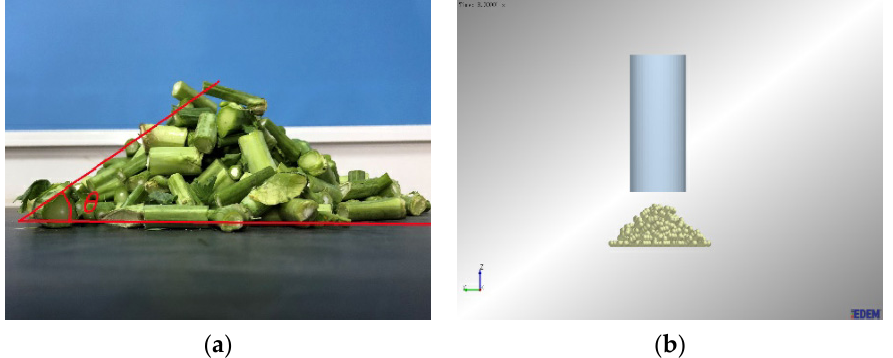
Figure 4. Experimental and simulation plots of the stacking angle. ( a ) Experiment; ( b ) Simulation [63].